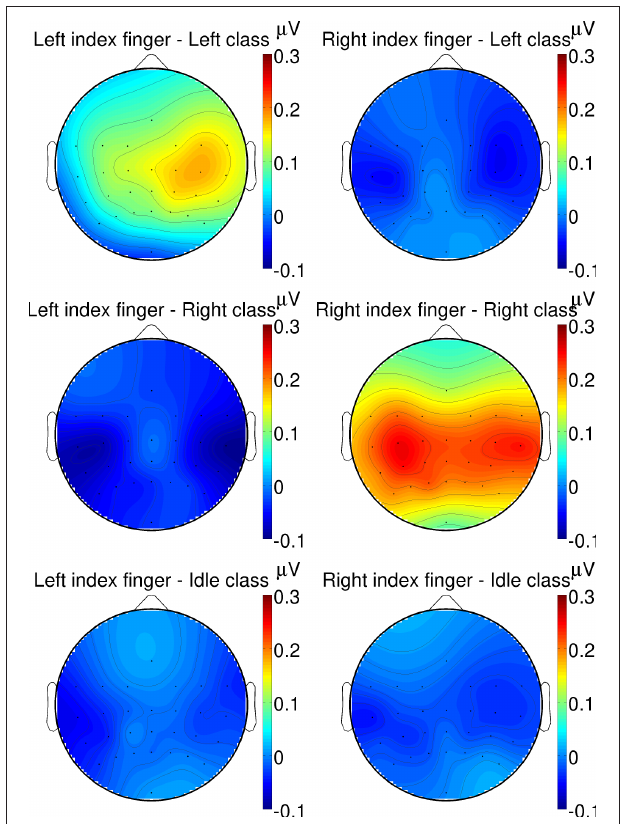
FIGURE 9 | Grand average topographic plots of the P300 response. The spatial distribution of the P300 component extracted from a 200–500ms time window is shown for different twitch locations (left/right column: left/right hand) and target classes (from top to bottom: left/right/idle cue).